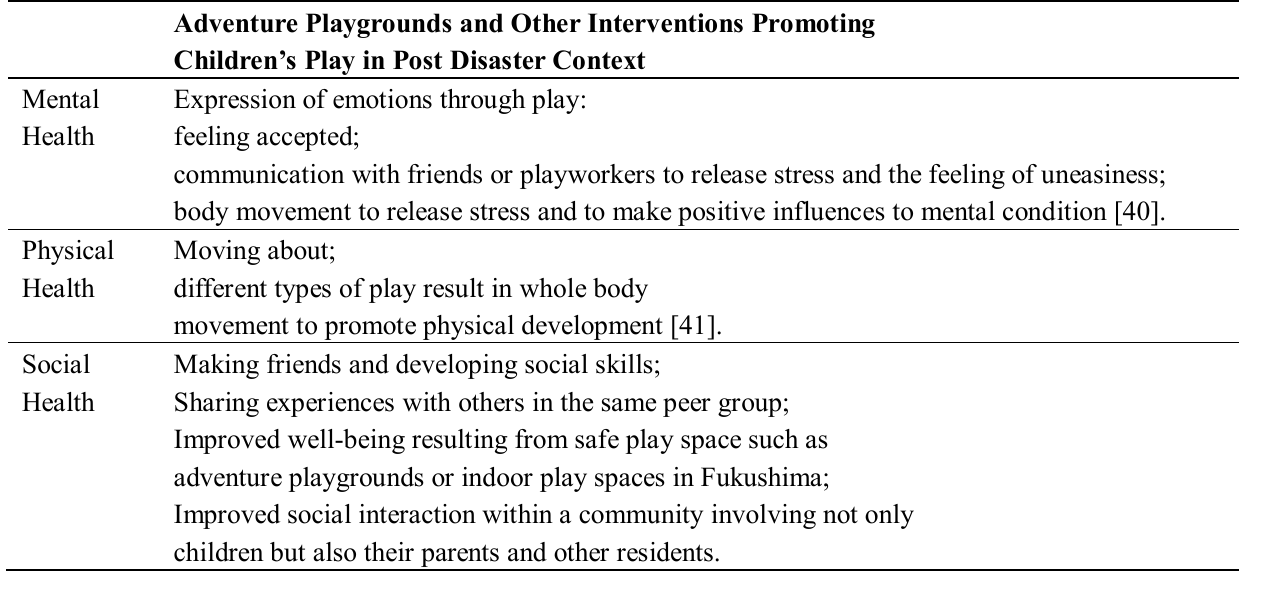
Table 3. Impact of interventions such as adventure playgrounds in children’s play in a post disaster context in